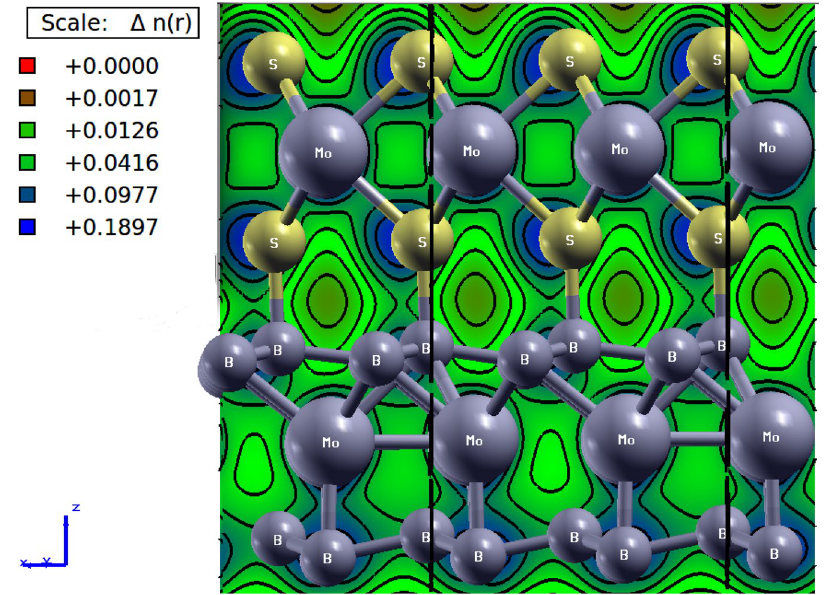
Figure 7. Charge density plot of MoS 2 / MoB 2 HS in [010]